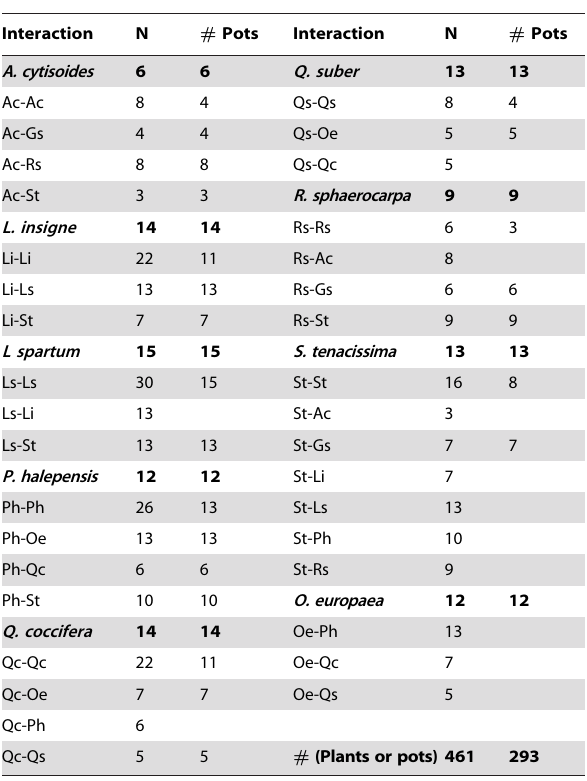
Table 2. Experimental